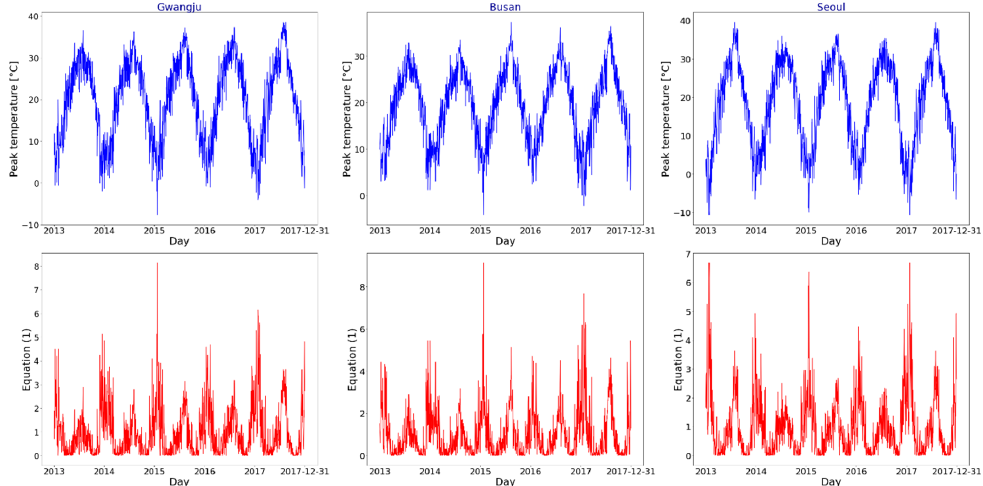
Figure 12. Graphs of temperature and graphs of results applied to Equation (1).